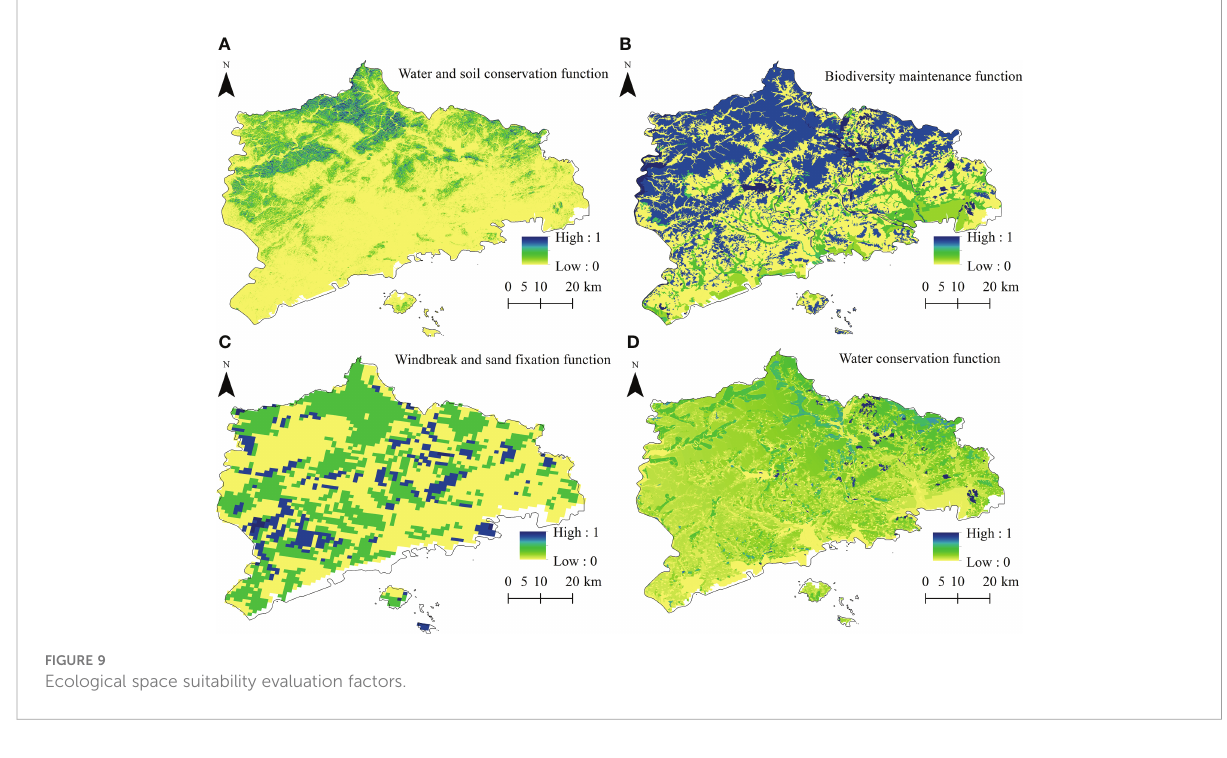
FIGURE 9 Ecological space suitability evaluation factors.